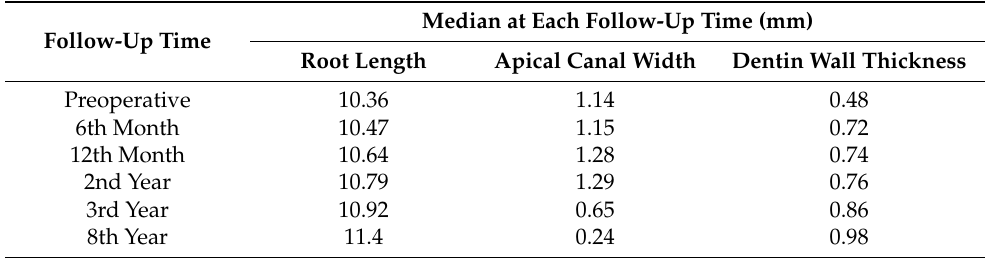
Table 2. Median of root canal dimensional changes (in mm) after regenerative endodontics procedure. Follow-Up